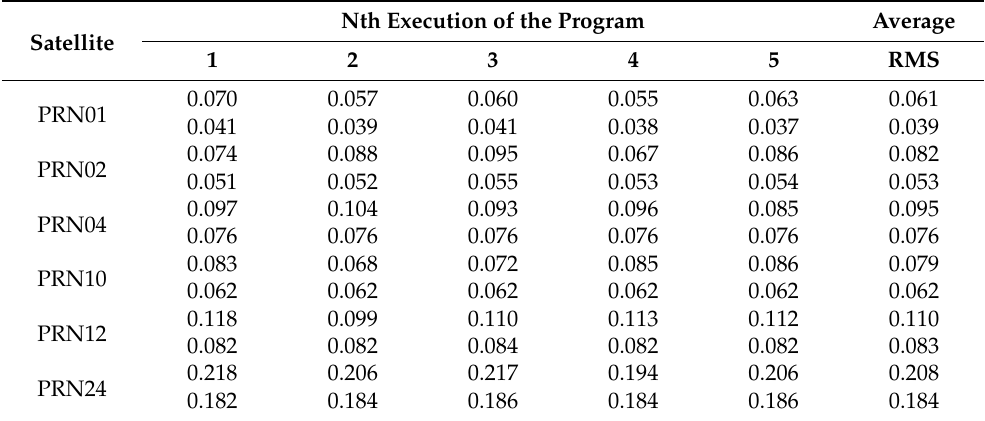
Table 3. Prediction precision of the BP model and the HPSO-BP model for five forecasts of six satellites (10-min forecasting) (Unit: ns, RMS is the root mean square).